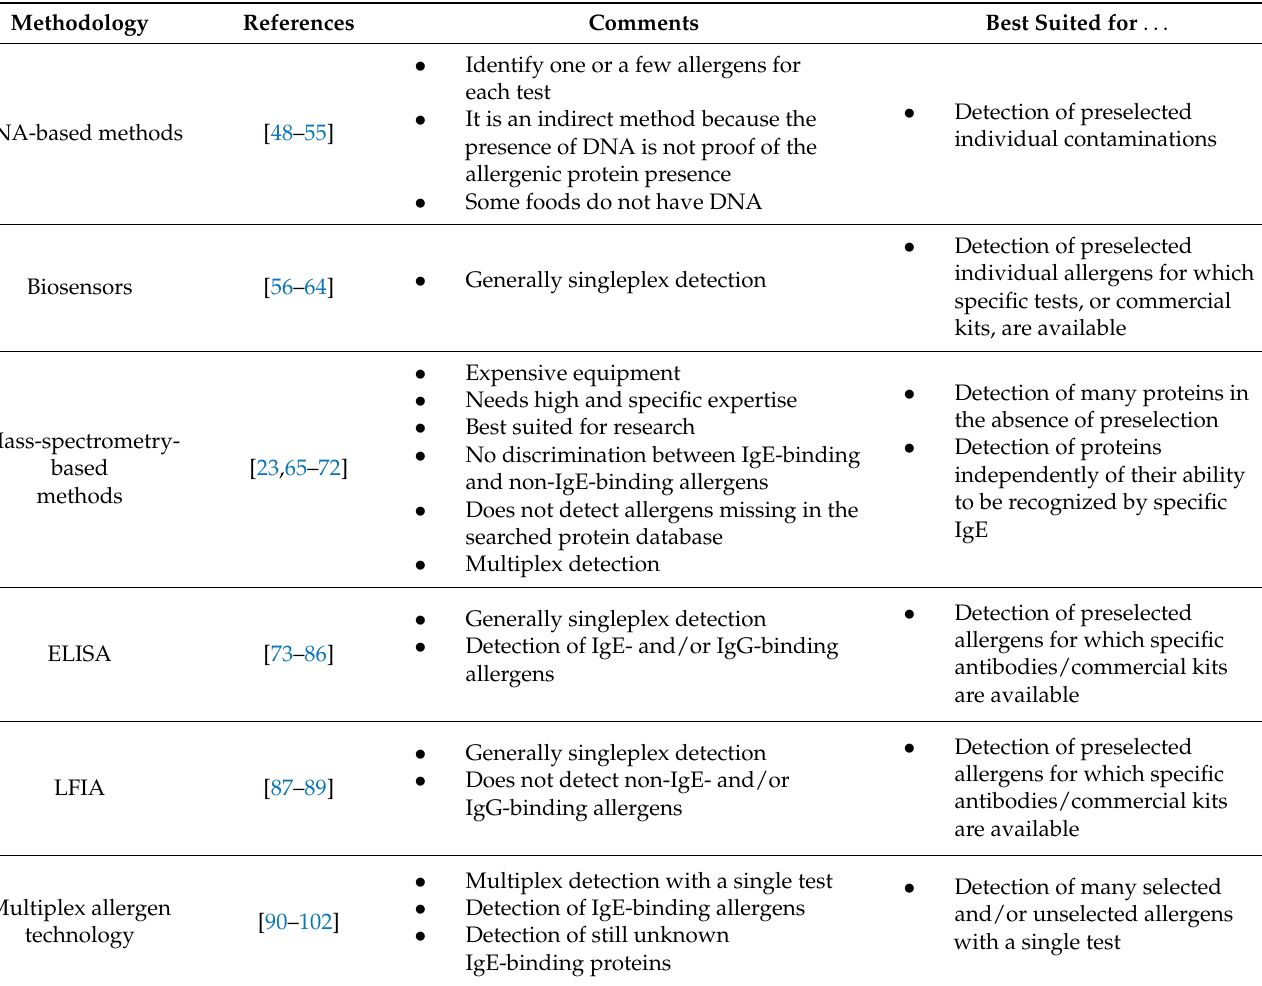
Table 1. Analytical methods for allergen detection in